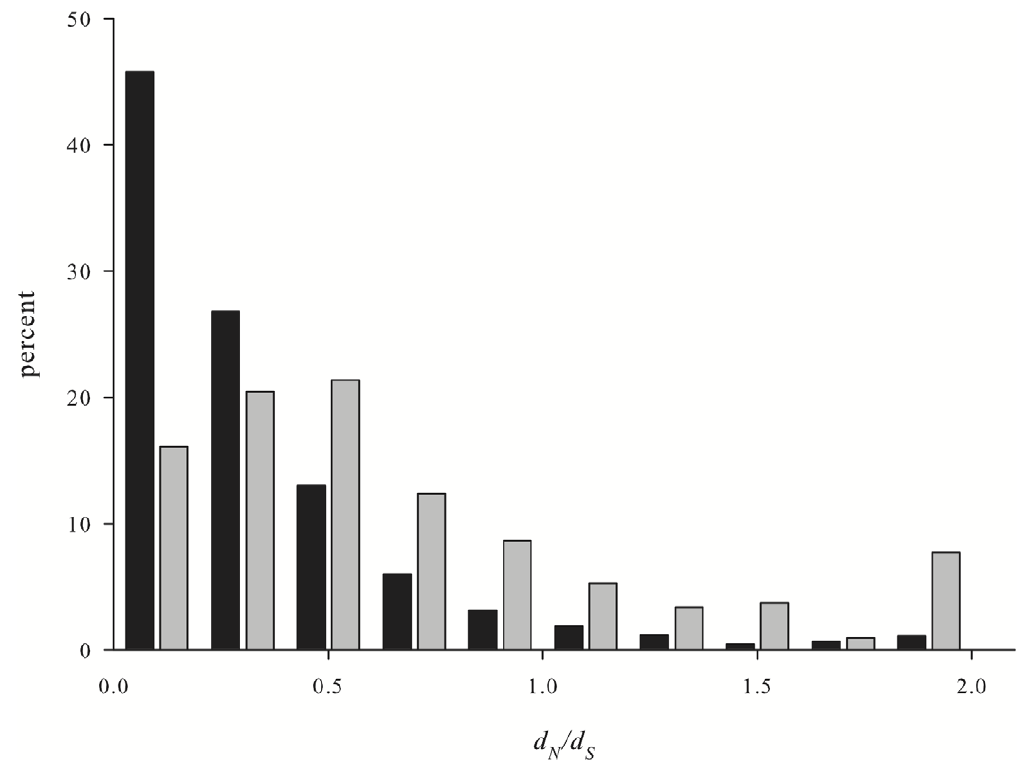
Figure 1. Discrete distribution of d N /d S ratios. The percentages of conserved (black bars) and lineage-specific (grey bars) genes falling into the respective d